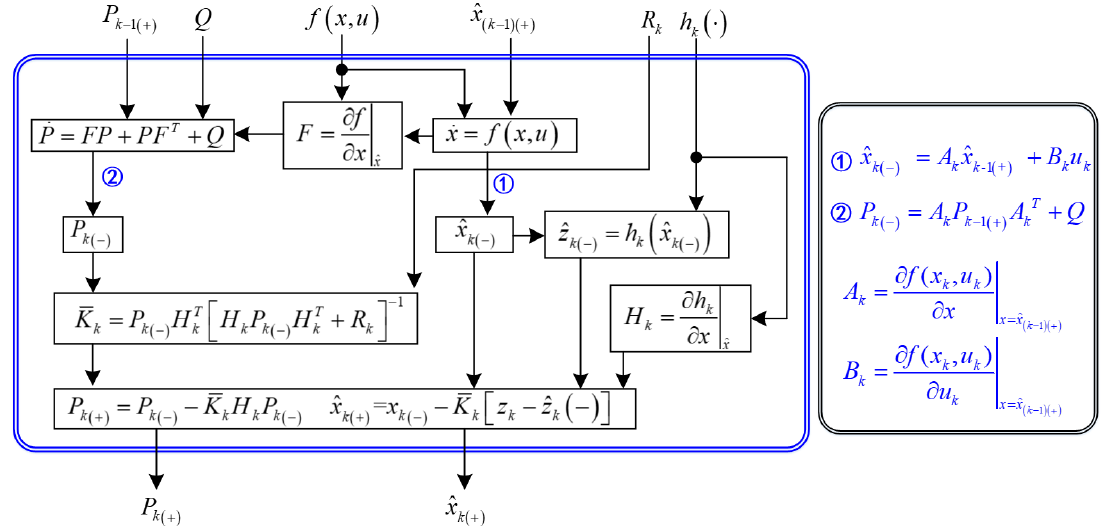
Figure 6. Schematic of extended kalman filter (EKF).